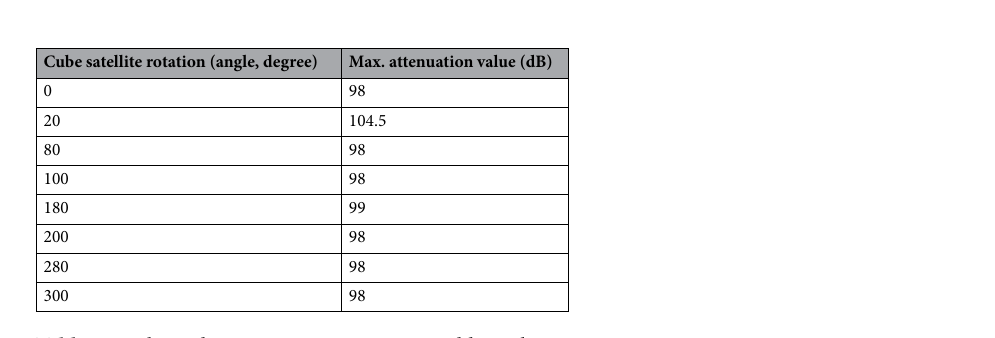
Table 2. Achieved maximum attenuation to address the maximum FSPL.